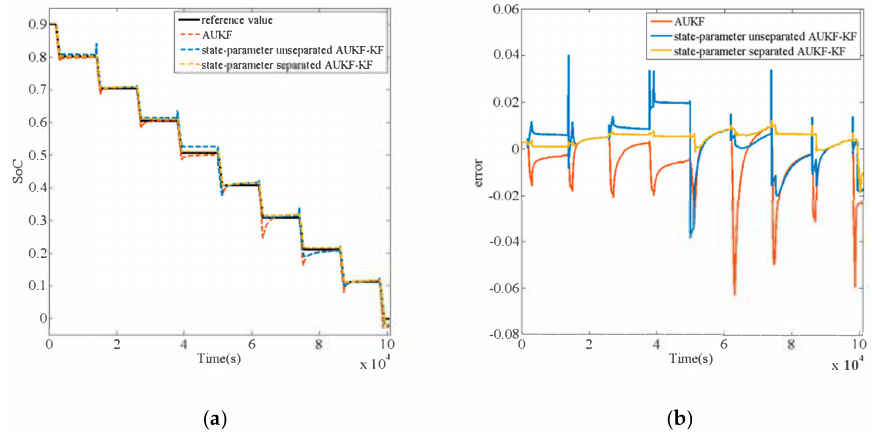
Figure 12. ( a ) The comparison of the SoC estimation between three algorithms under HPPC test; ( b ) The comparison of the SoC estimation error between three algorithms under HPPC test.